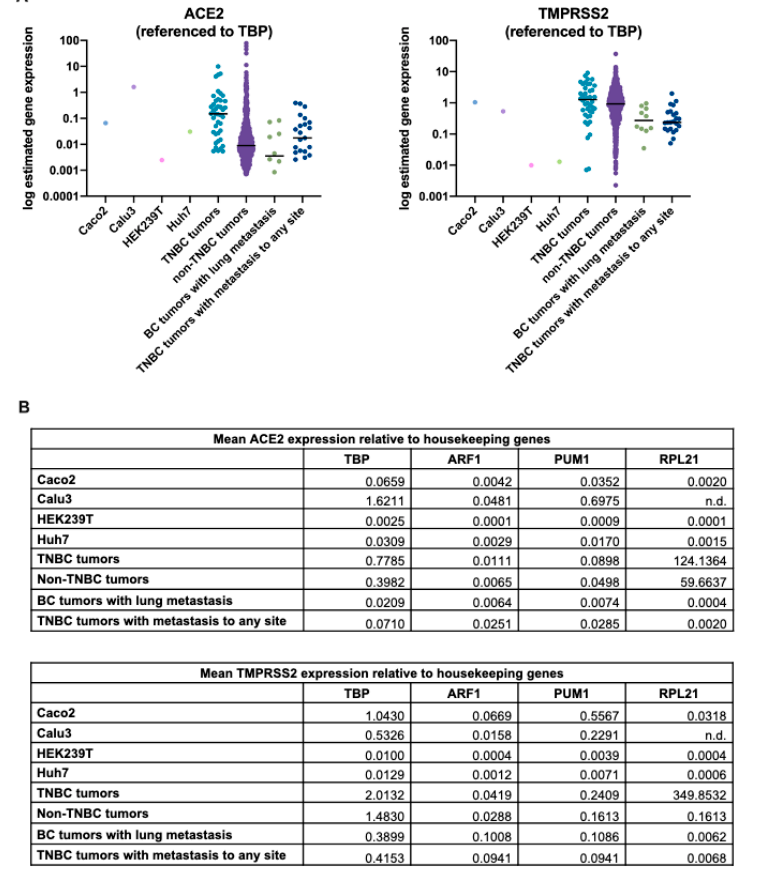
Figure 1. ACE2 and TMPRSS2 expression in breast cancer is comparable to cell lines permissive to SARS-CoV-2 infection. To compare expression of ACE2 and TMPRSS2 across datasets, we normalized the data to four different reference genes and depicted these as dot plots in ( A ) to one reference gene ( TBP ) and summarized in table format in ( B ) for all four reference genes ( TBP, ARF1 , PUM1, RPL21 ). TPM normalized gene expression for ACE2 and TMPRSS2 in four human cell lines permissive to COVID-19 infection and replication: Caco-2 (colorectal adenocarcinoma cells), Calu-3 (lung cancer cells), HEK239T (embryonic kidney 293 cells), Huh7 (hepatoma cells), were calculated from raw RNA-seq counts obtained from NCBI’s Gene Expression Omnibus ( GEO ) Datasets database (GSE140066, GSE147507, GSE137556, GSE129277, respectively). Only the control/non-treated samples from each dataset were included in the above analysis. RNA Seq V2 RSEM normalized gene expression for TNBC and non-TNBC tumours was obtained through the Breast Invasive Carcinoma (TCGA, Cell 2015) dataset accessed through cBioPortal [65,66]. All metastatic tumor data (breast cancer (BC) tumors with lung metastasis, metastatic TNBC tumors) were acquired through The Metastatic Breast Cancer Project (Provisional, February 2020) retrieved using cBioPortal. The results for the metastatic dataset were normalized by RNA Seq V2 RSEM.). The results presented in Figure 1 were derived in part from data generated by The Cancer Genome Atlas (TCGA) research network.